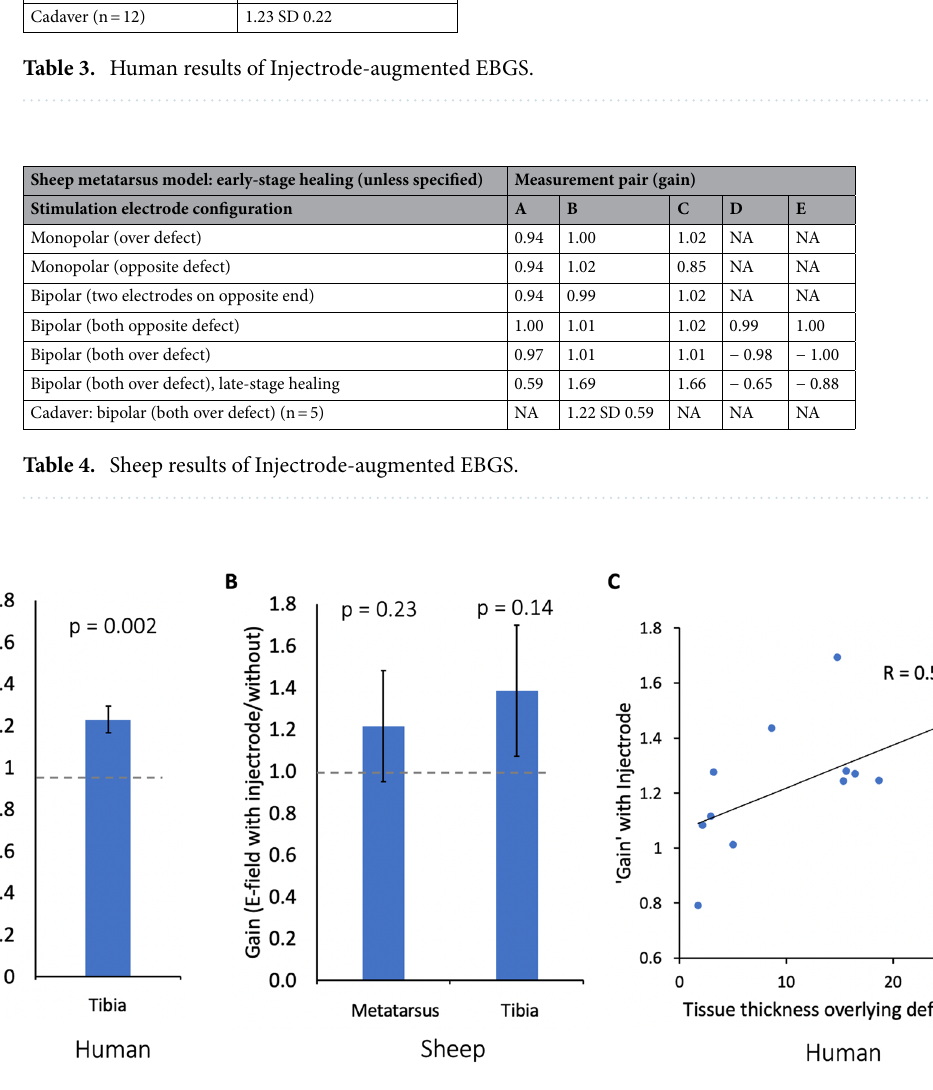
Figure 5. Injectrode increases electric field at fracture site when used with noninvasive EBGS therapy. ( a ) ‘Gain’ in electric field at tibial fracture defect with Injectrode-augmented EBGS therapy in human leg cadavers. Error bars indicate standard error of the mean (SEM). ( b ) ‘Gain’ in electric field at independent tibial and metatarsus fracture defects with Injectrode-augmented EBGS therapy in sheep leg cadavers. ( c ) Scatter plot showing increased utility of Injectrode to augment electric field at fracture site at increased bone